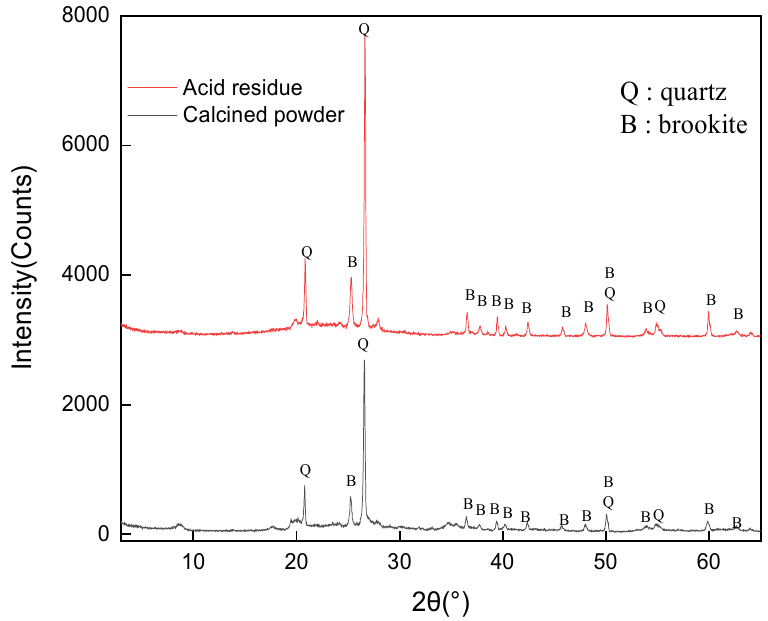
Figure 6. XRD spectra of gangue calcined powder and acid leaching filter residue.